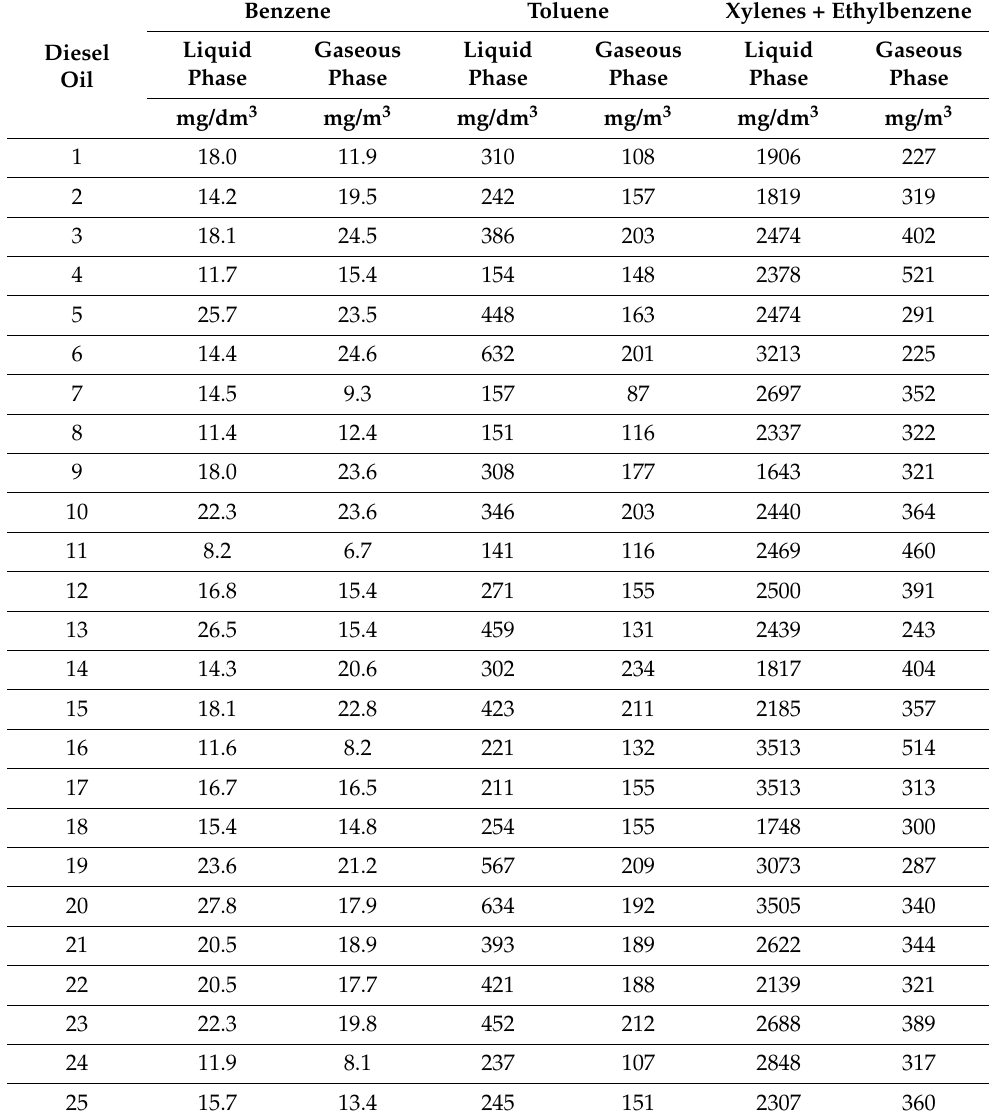
Table 2. BTEX concentrations in liquid and gaseous phases of diesel oil in equilibrium at a temperature of 40 ◦ C.